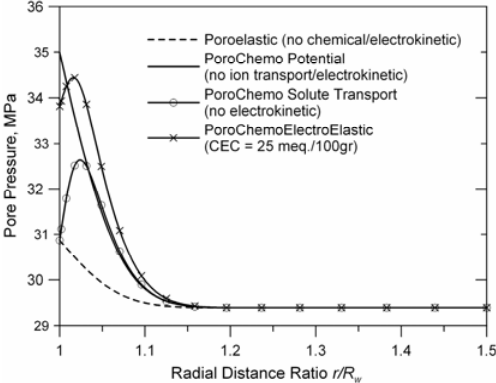
Fig. 3 – Pressure distribution in the formation after t = 15 minutes into drilling for high mud activity (low mud salinity): f . 93 > a f . 90. a o = 0 mud = 0